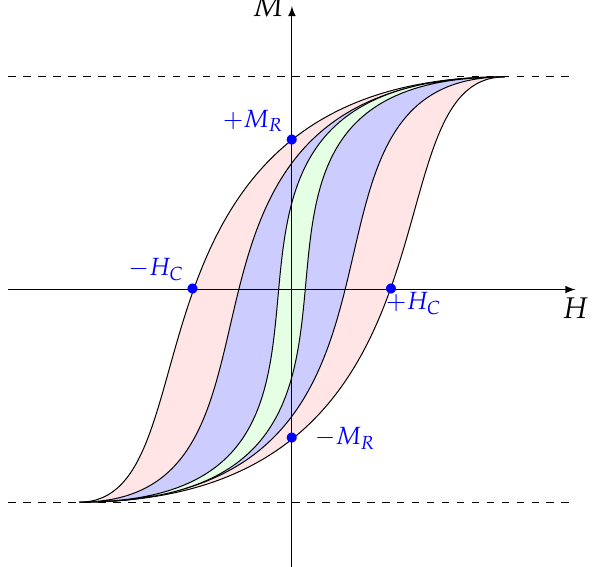
Figure 1. Hysteresis loops for hard (light red), semihard (light blue), and soft (light green) magnets. M the magnetization, H the applied magnetic field, M R remanent magnetization, and H C the